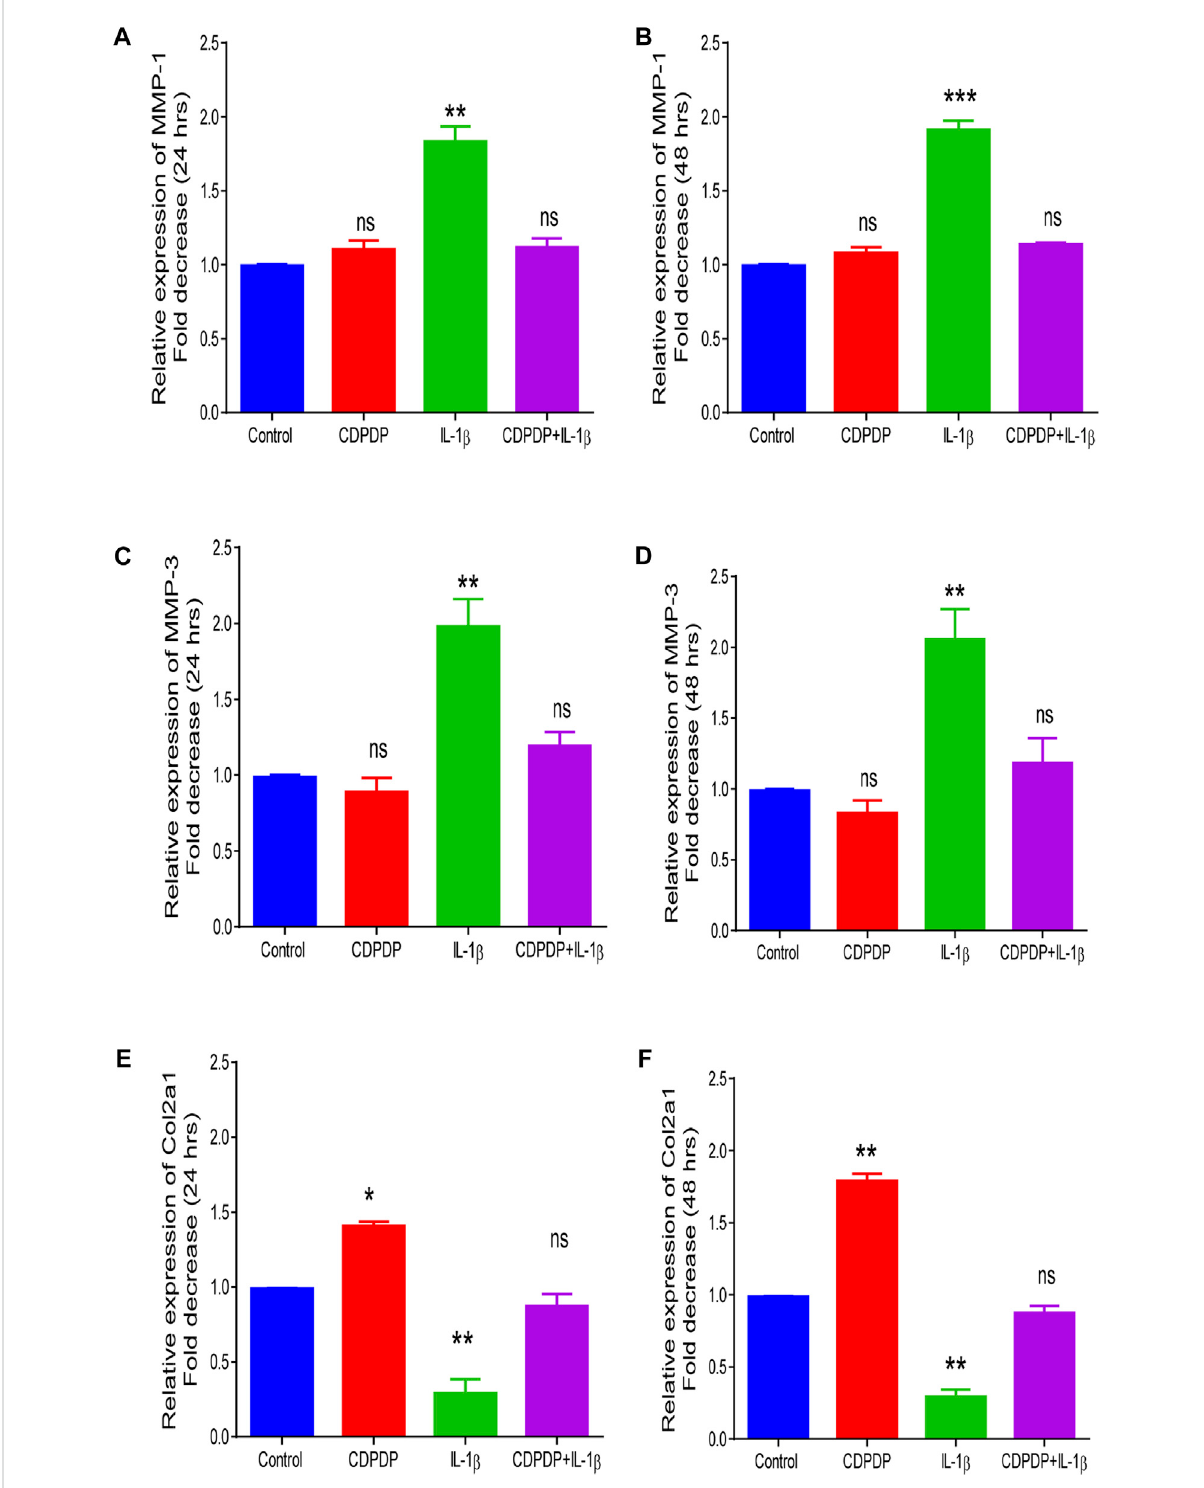
FIGURE 8 QuantitativePCRanalysischromatogram. (A) MMP-1after24 h (B) MMP-1after48 h (C) MMP-3after24 h (D) MMP-3after48 h (E) Col2a1after 24 h (F) Col2a1 after 24 h. Data is shown as mean ± SD ( n = 3). Means with different superscripts in the columns are signi fi cantly ( p < 0.05) different from one